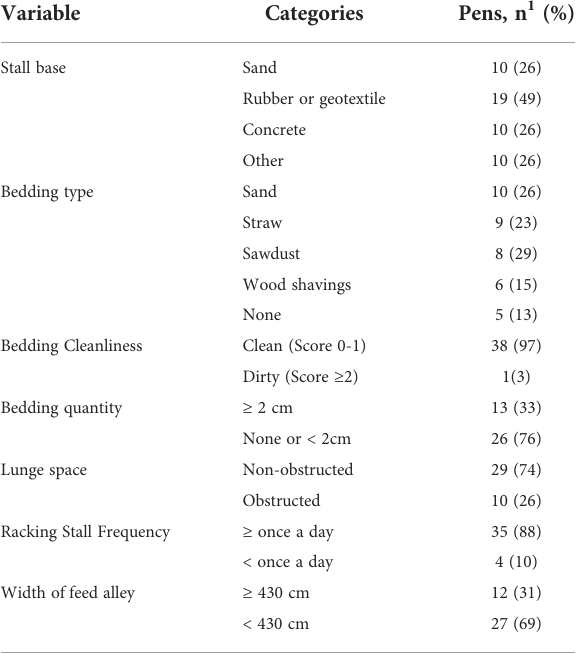
TABLE 2 Farm-level variables as measured in 39 pens from 36 dairy farms with AMS.